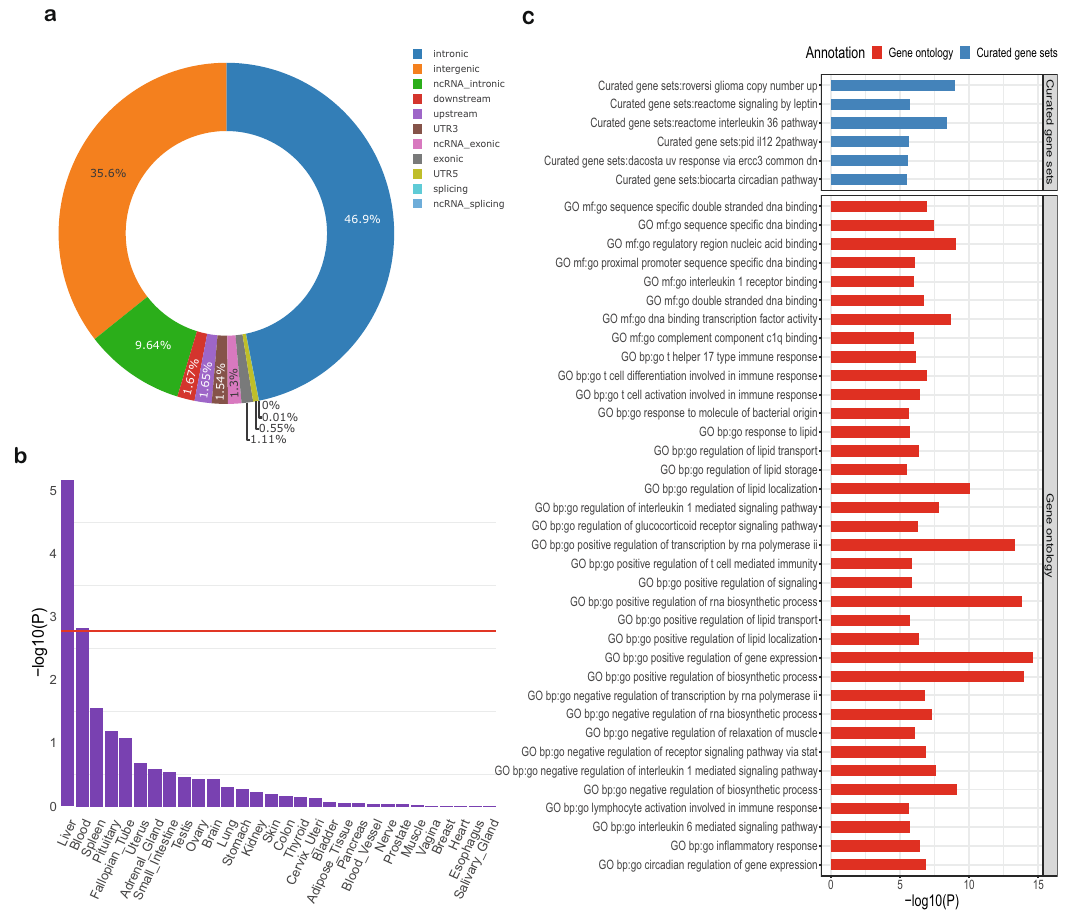
Fig. 3 Functional analysis of CRP based on functional annotation and MAGMA gene-property analysis. a Functional annotation of the variants in the genomic risk loci of the CRP meta-analysis by ANNOVAR plotted by the proportion of annotated SNPs (independent signi fi cant). b MAGMA gene- property analysis results are shown for average expression of 30 general tissue types, the red line indicates the Bonferroni threshold ( p = 1.67 × 10 − 3 ). c MAGMA gene-set analysis plot of the Bonferroni signi fi cant ( p < 3.23 × 10 − 6 )